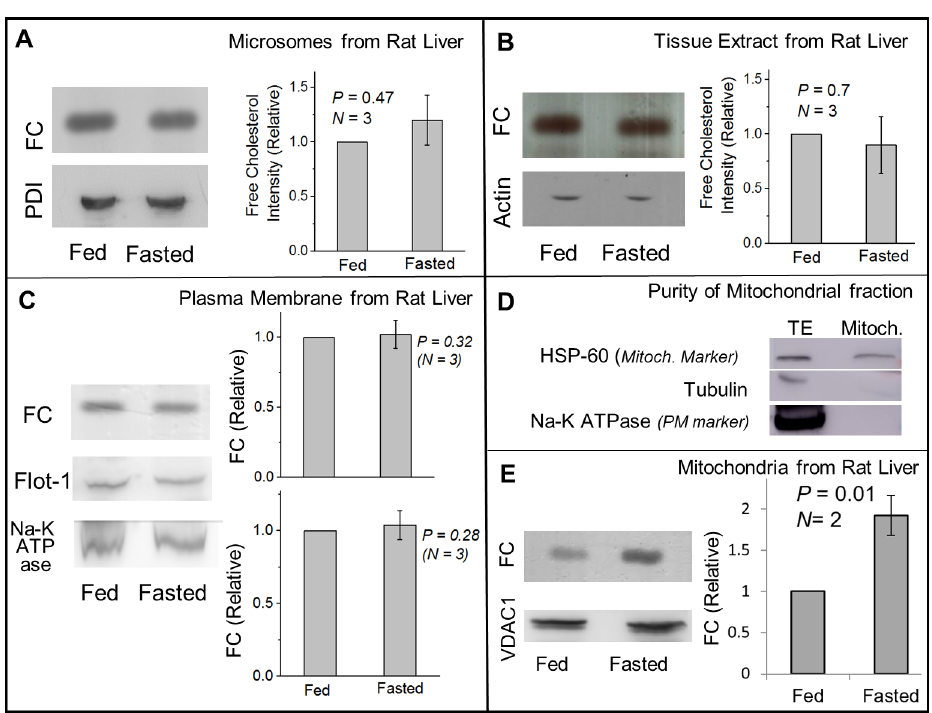
Fig 3. Comparison of free cholesterol levels between fed and fasted states on ER-enriched microsomes, liver tissue extract,plasma membrane and mitochondria. (A) TLC showingequal FC levels in microsomes isolatedfrom liver of fed and fasted rats. Equal loadingwas confirmedby western blotting for the ER marker PDI. Statistical analysisshows no significantchange in FC levels in ER after fasting. Error bars are SEM. (B) TLC showingequal FC levels in total liver lysate preparedfrom fed and fasted rats. Western blottingfor actin shows equal loadingof liver lysate samples. Error bars are SEM. (C) TLC showingequal FC levels in PM-enrichedmembranefractions isolatedfrom liver of fed and fasted rats. Flotillin-1also shows no changebetweenthese states. Western blottingfor Na-K ATPase (PM marker) confirms equal loadingof samples. There is no statistical difference in FC or Flot-1 levels on PM betweenfed and fasted liver. Error bars are SEM. (D) To determine the purity of mitochondria fraction, equal amount of protein of liver tissue extract (TE) and mitochondria (Mitoch.) were loadedin a gel for western blotting. The fraction was enriched in mitochondrial marker protein HSP60. Cytosolic (tubulin)and plasma membrane(Na-K ATPase) markers could not be detected in this fraction. (E) TLC on liver mitochondria samples shows higherFC levels in fasted as compared to fed state. Samples were normalised for equal protein, as confirmedby presence of VDAC1 (mitochondria marker). A statistically significantincreaseis observedin FC in fasted state as comparedto fed state.